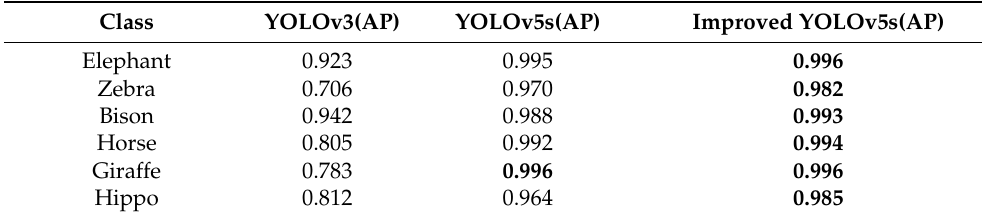
Table 2. Average Precision (IOU = 0.5) obtained for each evaluated object detection algorithm. Class